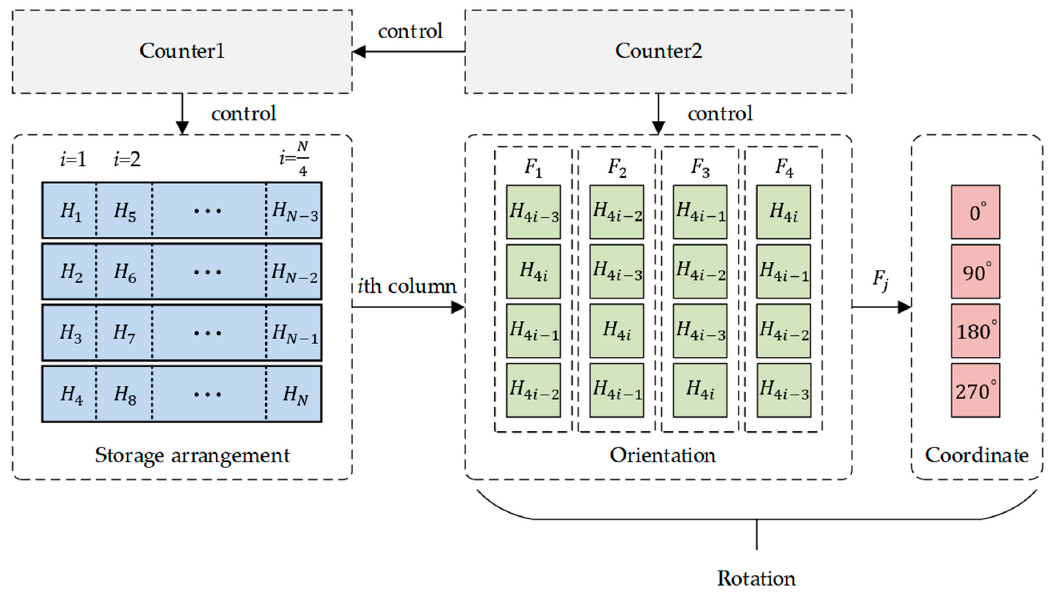
Figure 8. The process of generating the m- th input channel of A-ARF. 𝑚 = 4(𝑖 − 1) + 𝑗 , 𝑖 and controlled by counters. N is the number of the convolution kernel’s input 𝑗 are controlled by counters. 𝑁 is the number of the convolution kernel’s input channels.